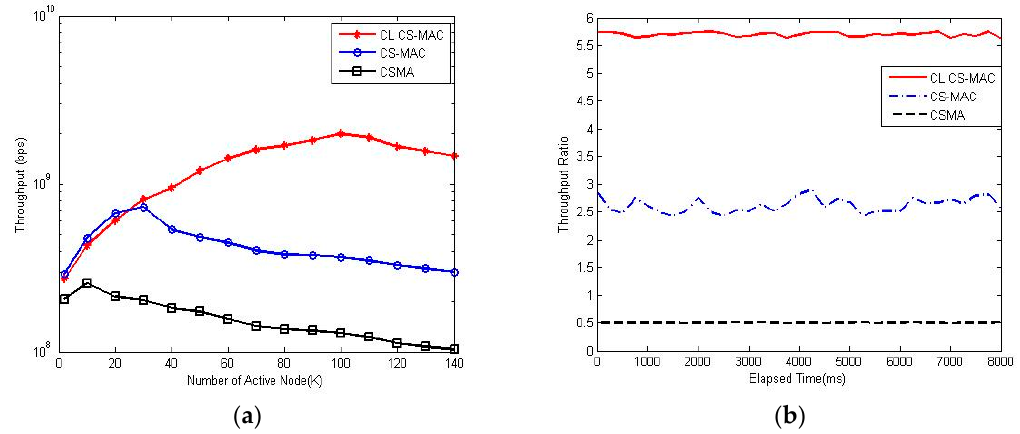
Figure 8. Software simulation result of throughput. ( a ) The throughput of different schemes. ( b ) The throughput ratio of different schemes.